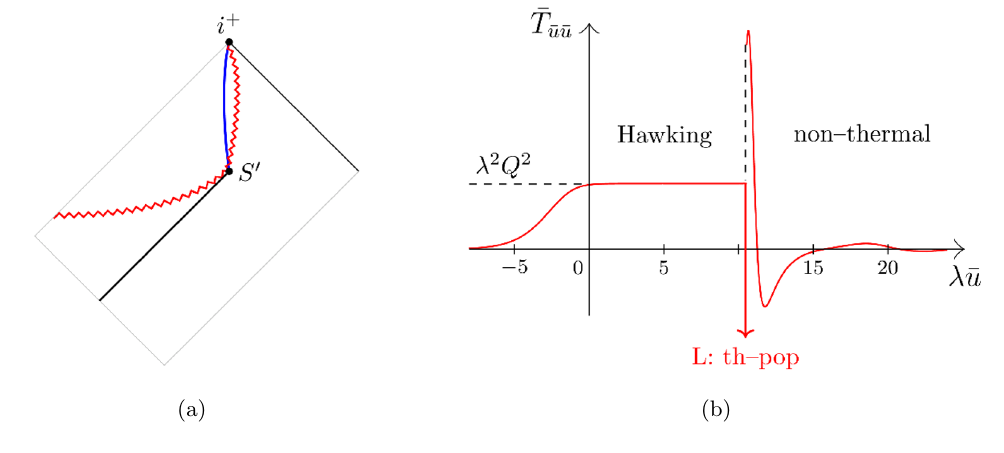
Figure 4 . (a) Solution with the second boundary violating eq. (3.30), cf. (cid:12)gure 2(c). (b) The asymptotic outgoing energy (cid:13)ux for the numerical solution in (cid:12)gure 2(c). trying to apply these solutions to computation of the e(cid:11)ective action (3.1). Indeed, the left border of the spacetime in (cid:12)gure 2(b) is not smooth but constructed from three time- and spacelike pieces (lines i (cid:0) S , SS 0 , and S 0 i + ). It is not clear how to evaluate the extrinsic curvature K and therefore the Gibbons-Hawking term (2.11) at the angles S and S 0 of these